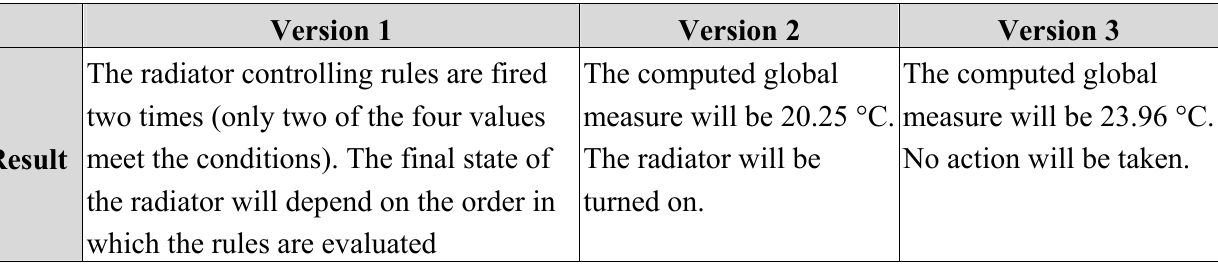
Table 4. Results of each version of the first